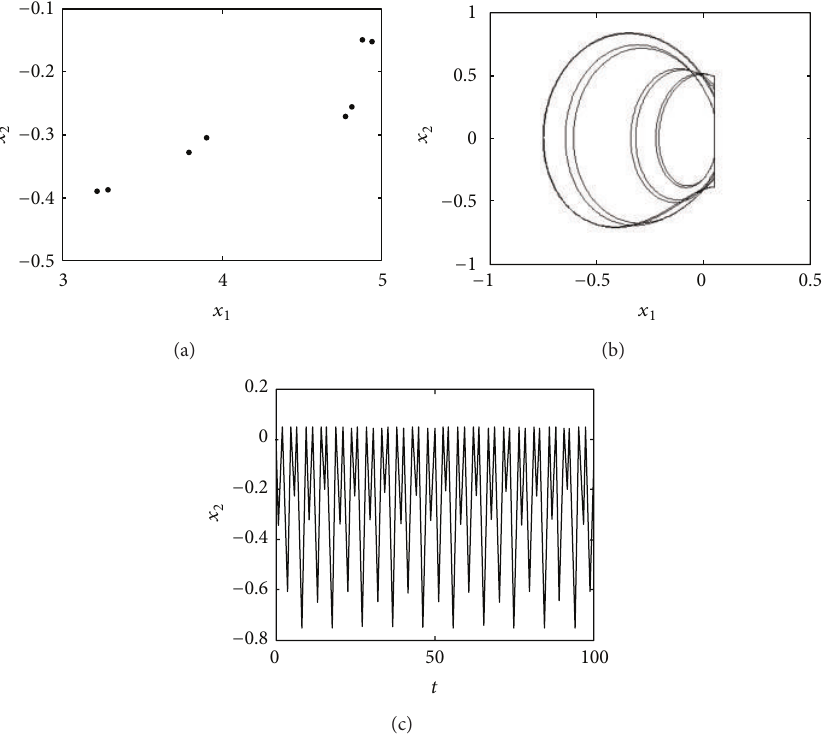
Figure 6: Poincar´e map, phase portrait, and time course diagram of the system with 𝜔 = 2.42 .